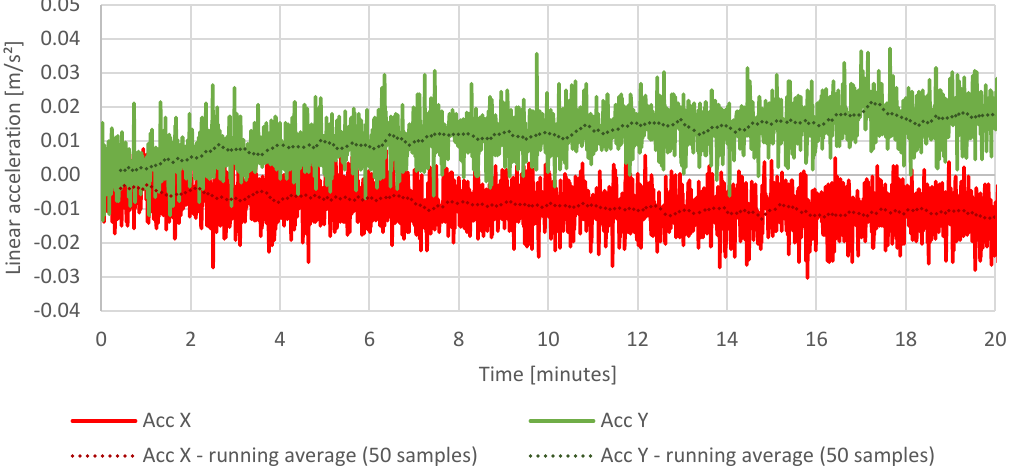
Figure 16. Stationary measurements of gyroscope drift.